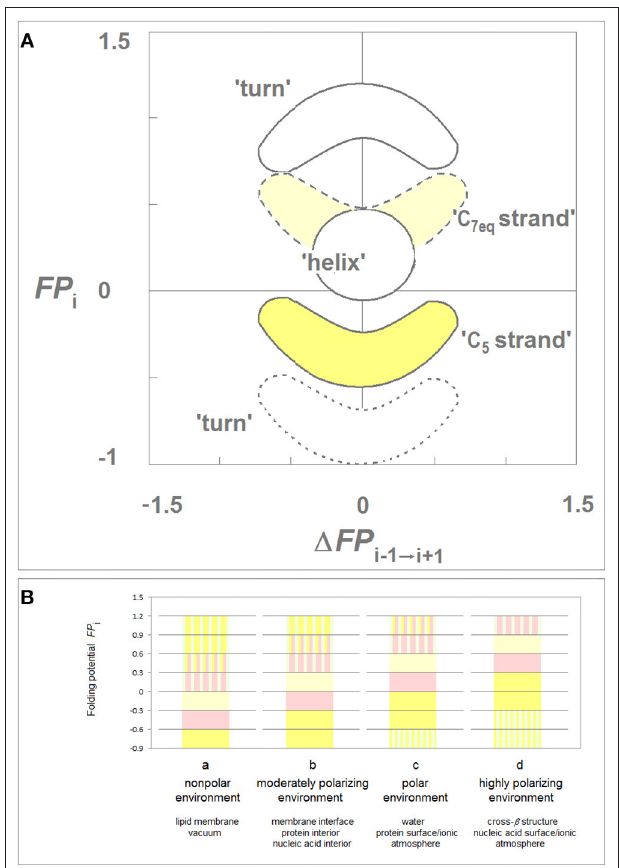
FIGURE 1 | Folding potential function FP i as a probe of the three-dimensional structure of proteins. (A) Characteristic clusters of the data sets in the plots of FP i vs. the “slope” of FP i , 1 FP i − 1 → i + 1 . The five clusters of data correspond to the three archetypal elements of the secondary structure: e.g., the presence of the archetypal “helix” will be marked by a compact cluster of data sets in the center of the plot. The ordinate of this cluster will vary since the optimal FP i value for “helix” depends on the medium’s capacity to polarize the protein, vide infra . Notice that “strand” and “turn” have each two avatars: (i) “C 5 strand” and “C 7eq strand,” and (ii) “ FP i >> 0 turn” (defined here as the three- or five-residue segment that incorporates Gly in the center) and “ FP i << 0 turn.” (B) Folding potential, medium properties and secondary structure preferences of the polypeptide backbone: (a) The FP i values that ensure stability of the periodic secondary structure in a non-polar environment such as the lipid matrix of the bilayer membrane or vacuum: the optimal FP i range for the α -helix is − 0.6 to − 0.3 and the optimal FP i ranges for β structure is < − 0.6 (C 5 strand) and − 0.3 to 0 (C 7eq strand). The less polarized segments are malleable in a non-polar aprotic medium and may adopt helical (3 1 -helix, PP II -helix, α *-helix) folds while the least polarized segments of the polypeptide backbone, e.g., a sequence of consecutive “ FP i >> 0 turns,” may adopt the